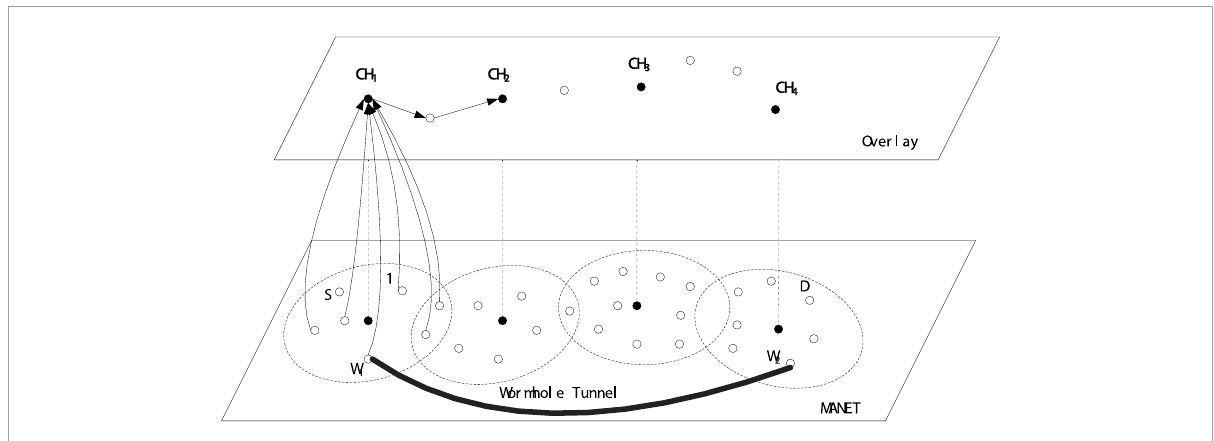
FIGURE 9 Location phase for locating the wormhole nodes.